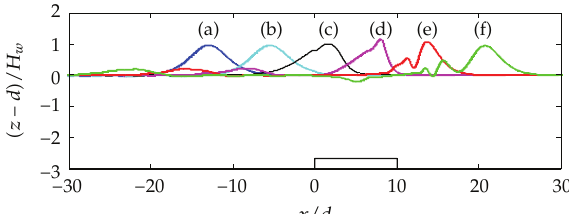
Figure 2: Transformation of a solitary wave travelling over a submerged breakwater with n (cid:7) 0 . 2 and D 50 (cid:7) 0 . 05m at di ff erent time levels: (cid:2) a (cid:3) t (cid:2) g/d (cid:3) 0 . 5 (cid:7) 35, (cid:2) b (cid:3) t (cid:2) g/d (cid:3) 0 . 5 (cid:7) 42, (cid:2) c (cid:3) t (cid:2) g/d (cid:3) 0 . 5 (cid:7) 49, (cid:2) d (cid:3) t (cid:2) g/d (cid:3) 0 . 5 (cid:7) 56,